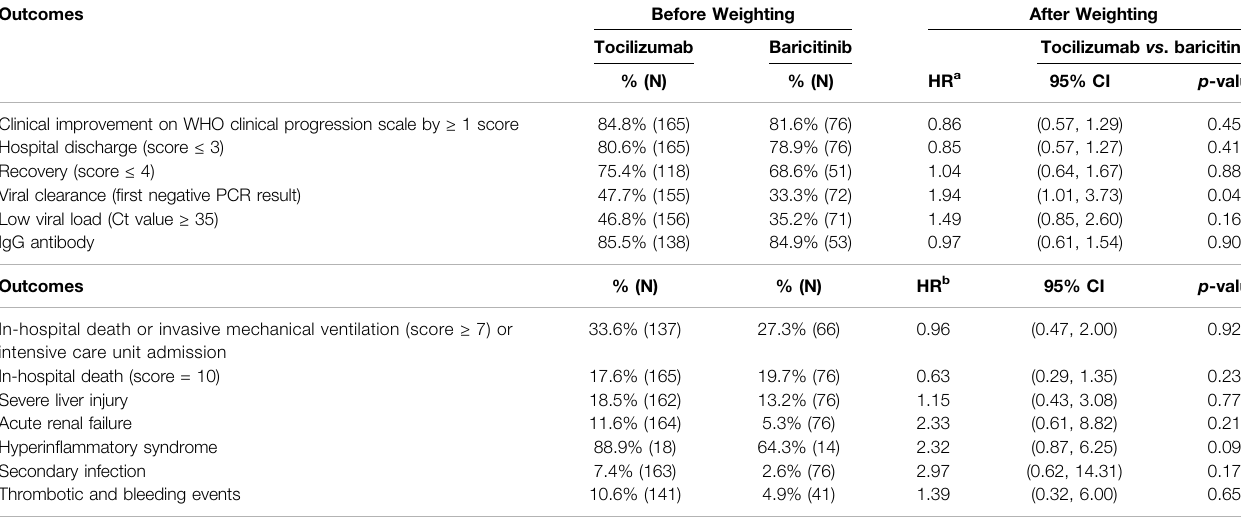
TABLE 2 | Comparison of clinical improvement on WHO clinical progression scale, hospital discharge, recovery, viral dynamics, clinical deterioration, in-hospital death, severeliverinjury,acuterenalfailure,hyperin fl ammationsyndrome,secondaryinfection,andthromboticandbleedingeventsbetweentocilizumabandbaricitinibgroups. Outcomes Before